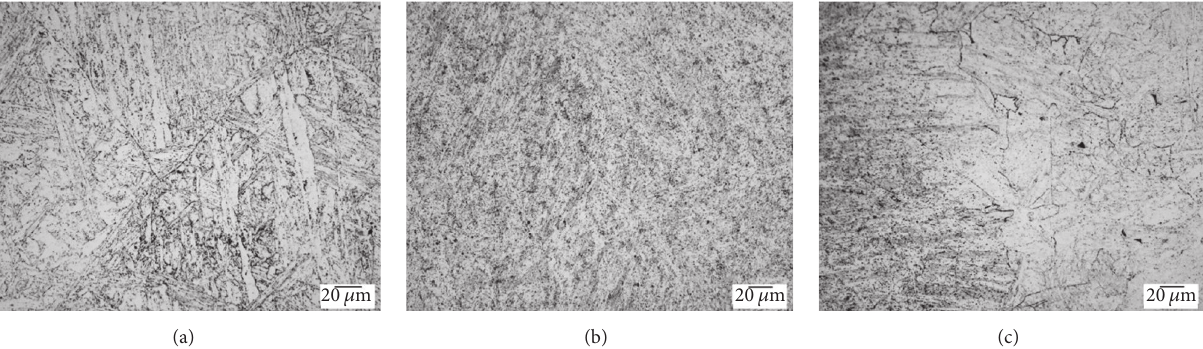
Figure 1: Light-optical microstructures of individual regions of studied CB2 weldment in PWHT state: BM (a), WM (b), and HAZ (c).